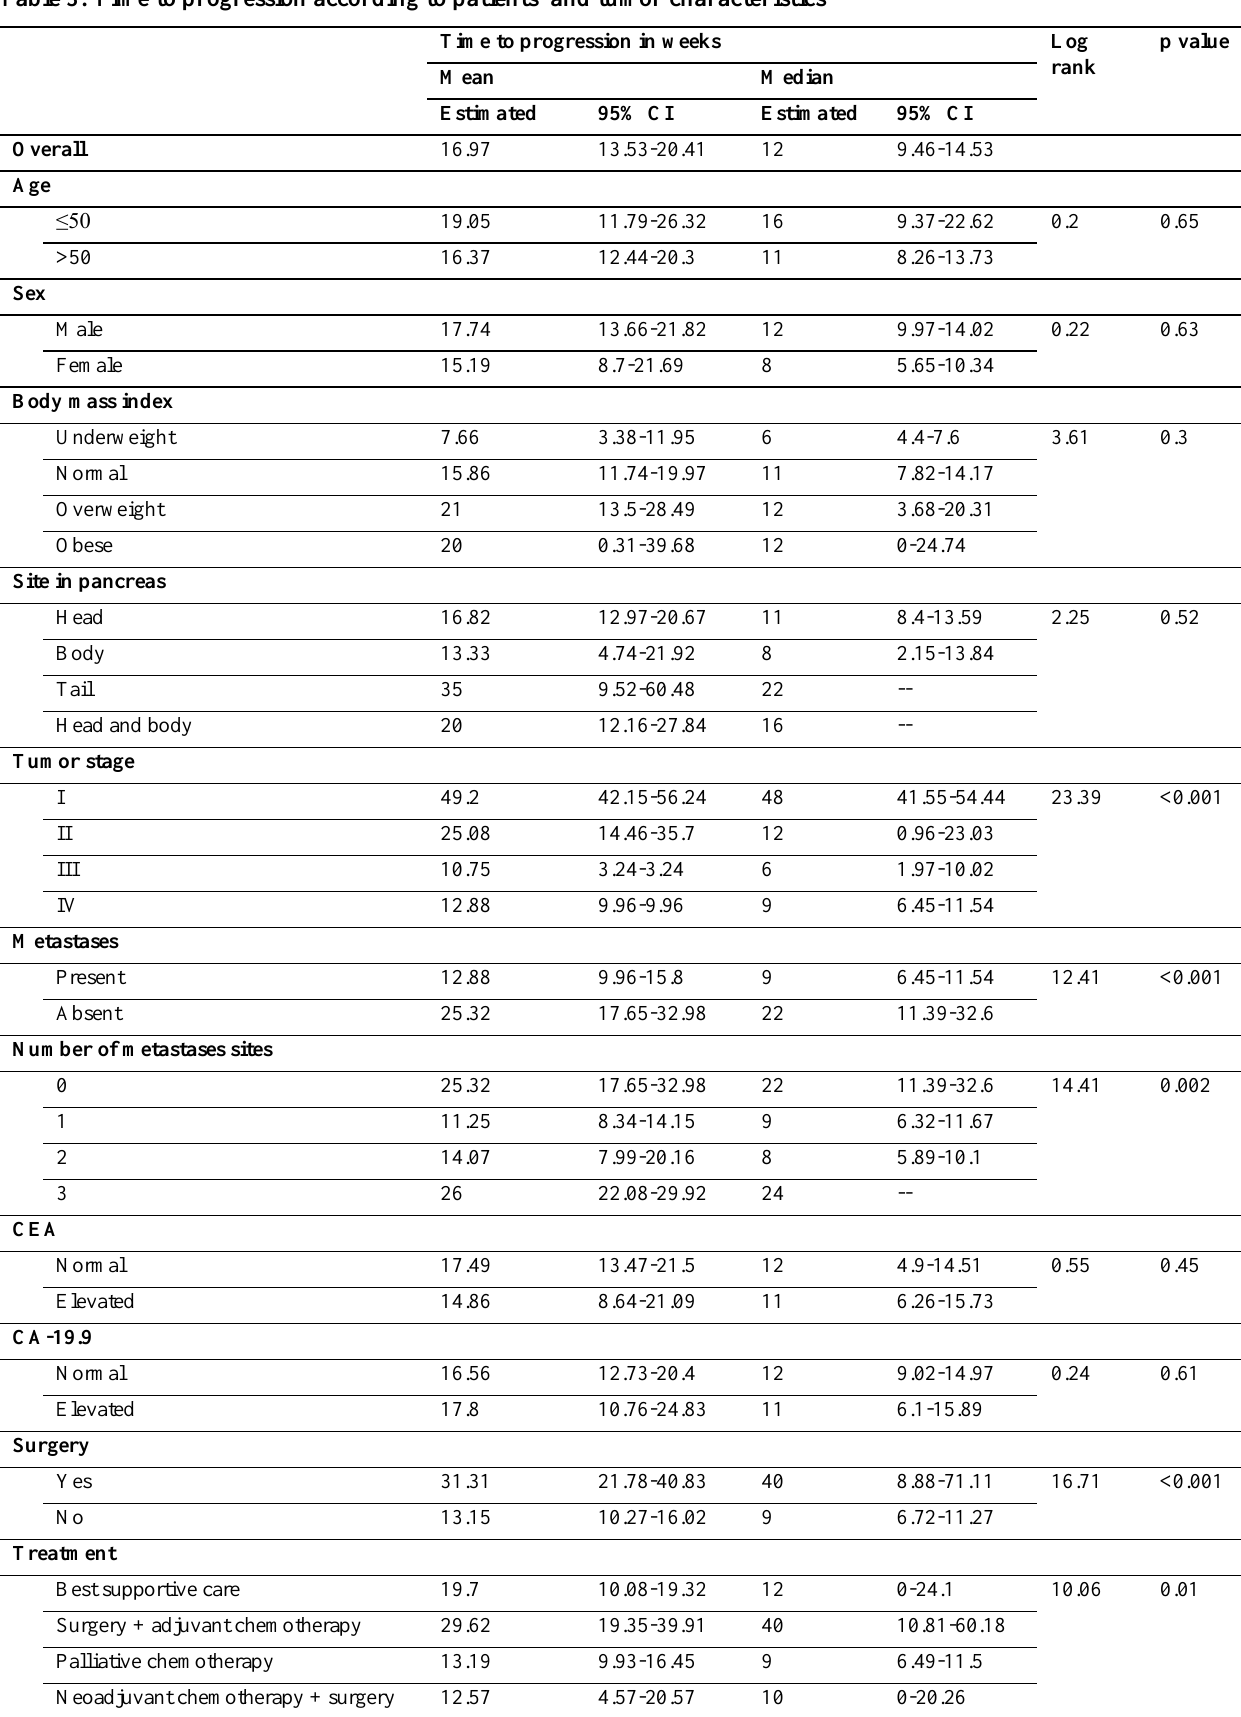
Table 3: Time to progression according to patients' and tumor characteristics Time to progression in weeks